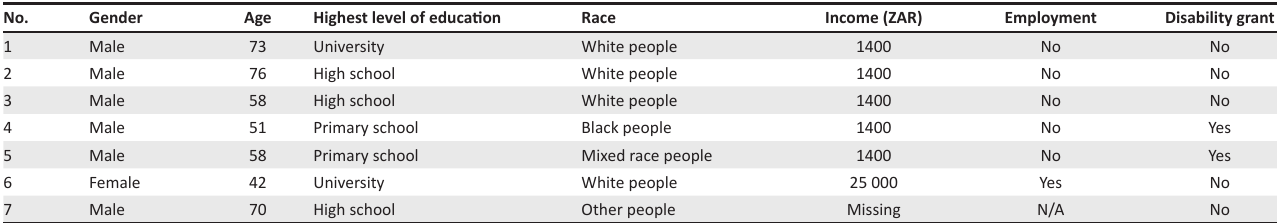
TABLE 4: Demographic details of the participants in the qualitative phase .